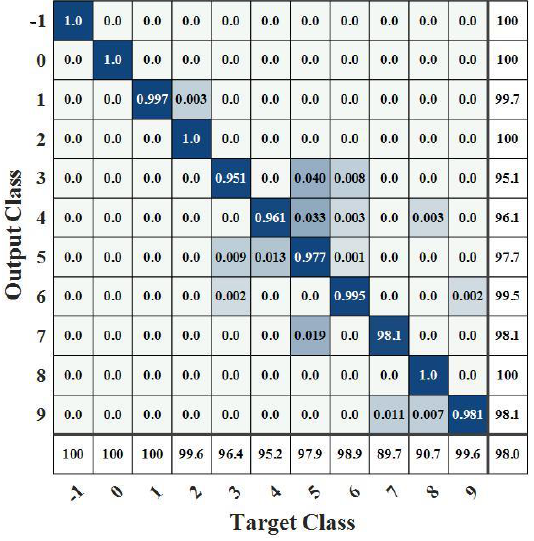
Figure 6. Confusion matrix 1 of working condition recognition.